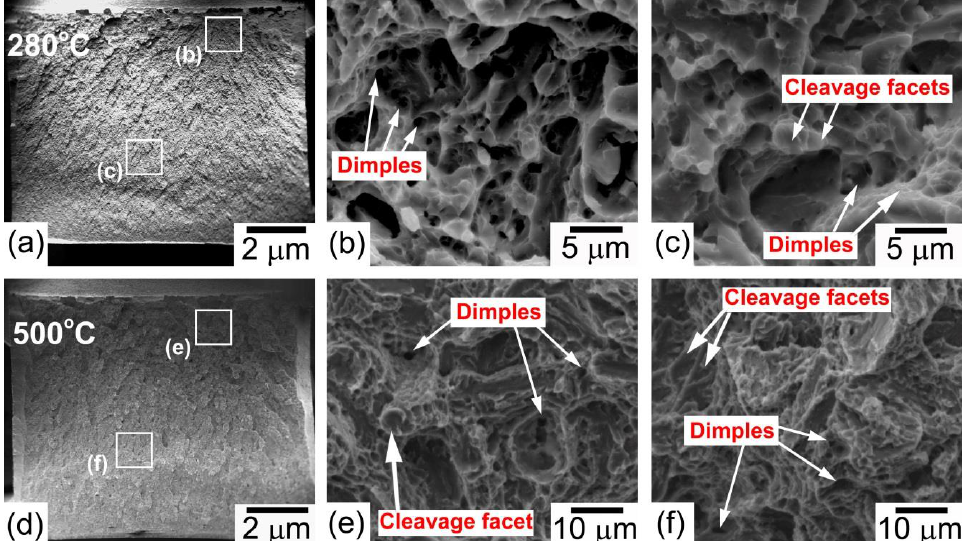
Figure 10. Fracture surfaces of the Charpy V-notch specimens after tempering at 280 °C ( a – c ) and 500 °C ( d – f ) tested at 20 °C: general view ( a , d ) and high magnification of the portions indicated by frames ( b , c , e , f ).